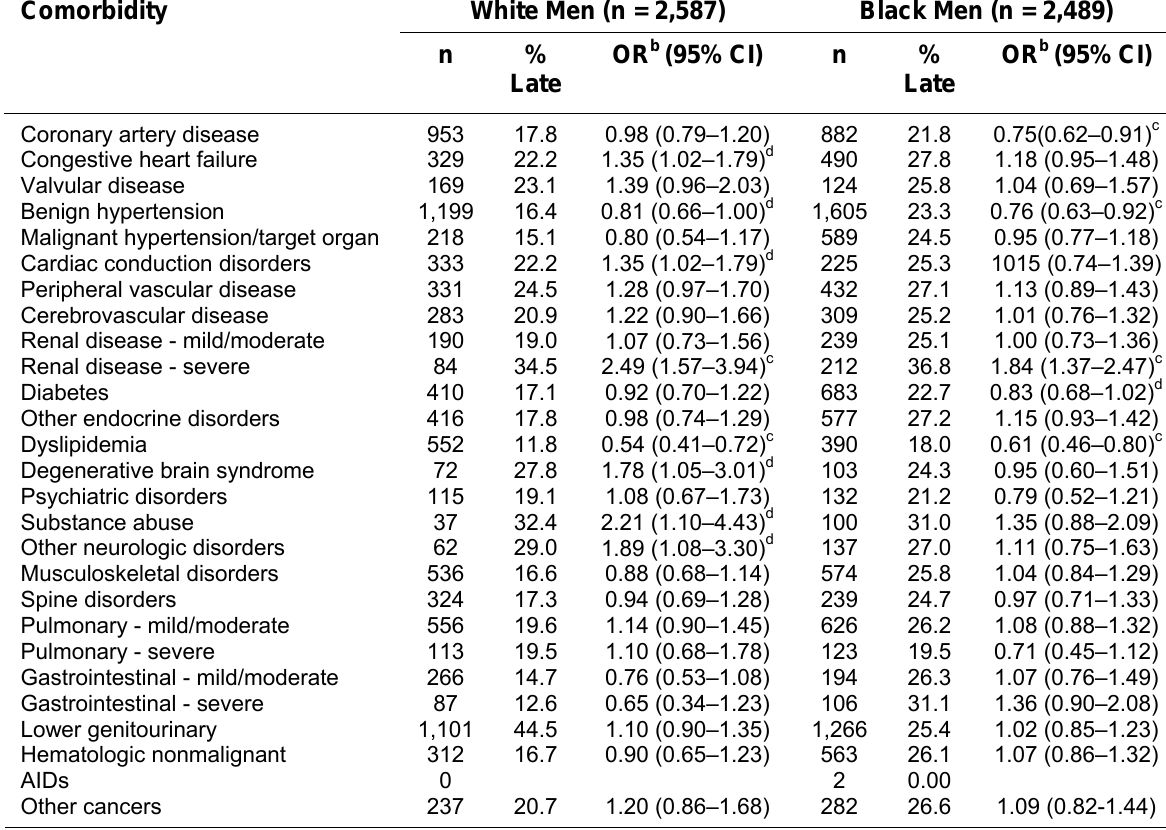
statistic, p < 0.01; d = Chi-square